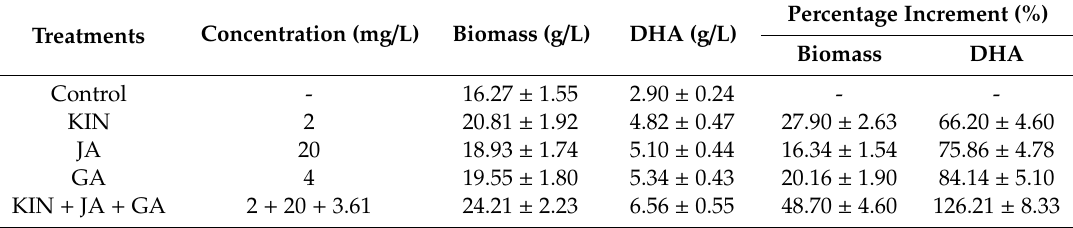
Table 2. Comparison of biomass, DHA production and percentage increment, with the control set as the reference, by SW1 after 96 h of cultivation supplemented with the synergistic optimal concentration of KIN, JA and GA. Values represent the means and the standard deviations of triplicate experiments ( n =